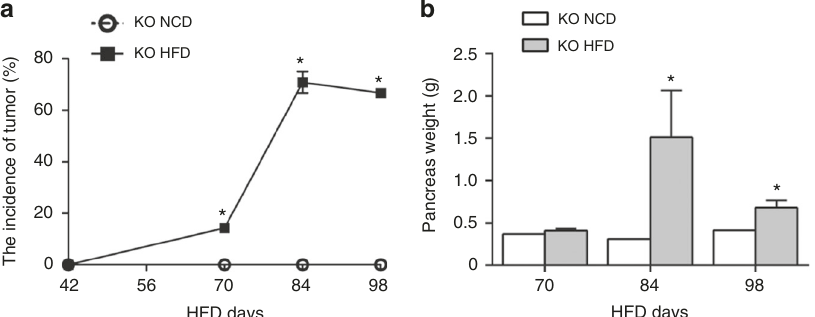
Fig. 5 Effect of HFD on the development of pancreatic ACC in Ngn3-Tsc1 − / − mice. a Pancreatic ACC incidence. b Pancreatic weight Ngn3-Tsc1 − / − (KO) mice at 6-weeks-old were fed with 45% HFD or NCD for 4, 6, and 8 weeks. Animals were sacri fi ced and pancreas assessed for ACC. n = 8 and 7 for 70- days-old KO mice fed HFD or NCD for 4 weeks, respectively; n = 11 and 7 for 84-days-old KO mice fed HFD or NCD for 6 weeks, respectively; n = 7 and 6 for 98-days-old KO mice fed HFD or NCD for 8 weeks, respectively. Values are mean ± SEM. * P < 0.05 Ngn3-Tsc1 − / − (KO) HFD vs. Ngn3-Tsc1 − / −